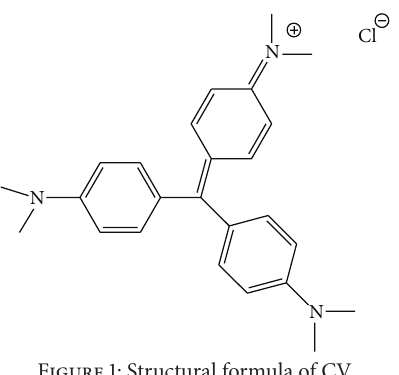
Figure 1: Structural formula of